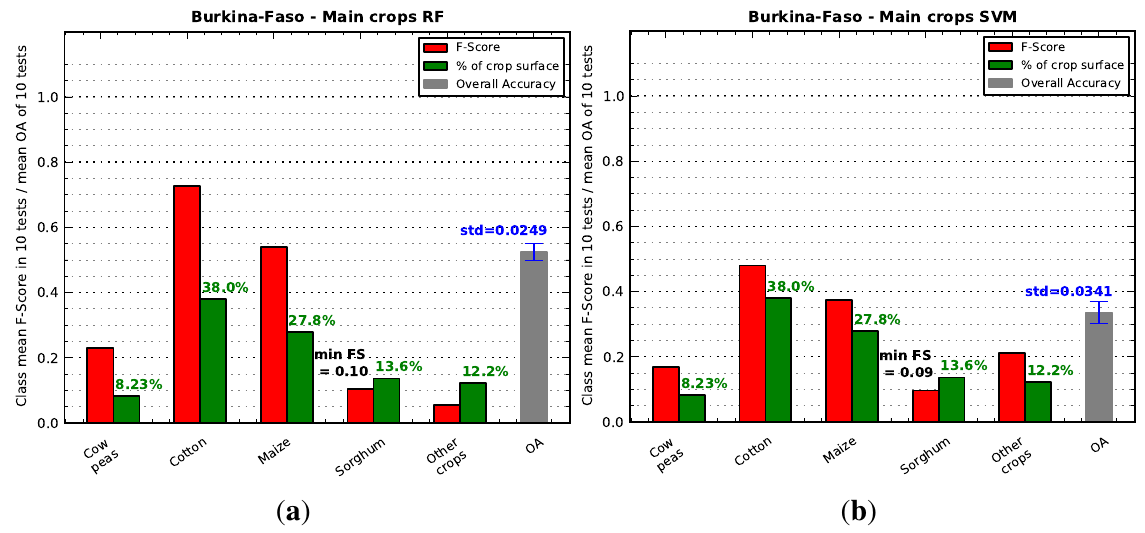
Figure 8. F-score and OA results for RF and SVM for the Burkina Faso test site. ( a ) RF; ( b ) SVM.